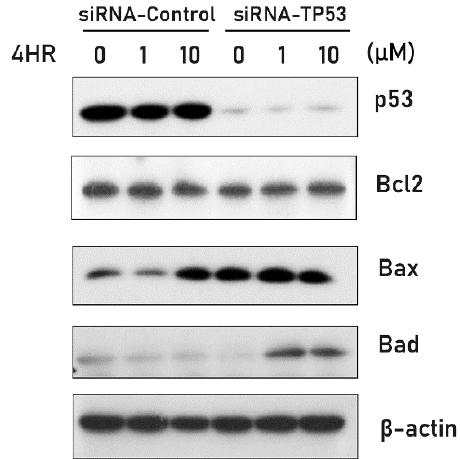
Figure 5. Transfection with TP53 siRNA. TP53 siRNA inhibited p53 expression successfully. The expression levels of Bcl-2 were not dependent on the presence of p53. When 4HR was added to TP53 mutant oral cancer cells (YD-15), the expression levels of Bax were increased. Interestingly, the expression levels of Bax were increased upon transfection with TP53 siRNA. Interestingly, treatment with 4HR increased the expression levels of Bad protein in a p53 independent manner.